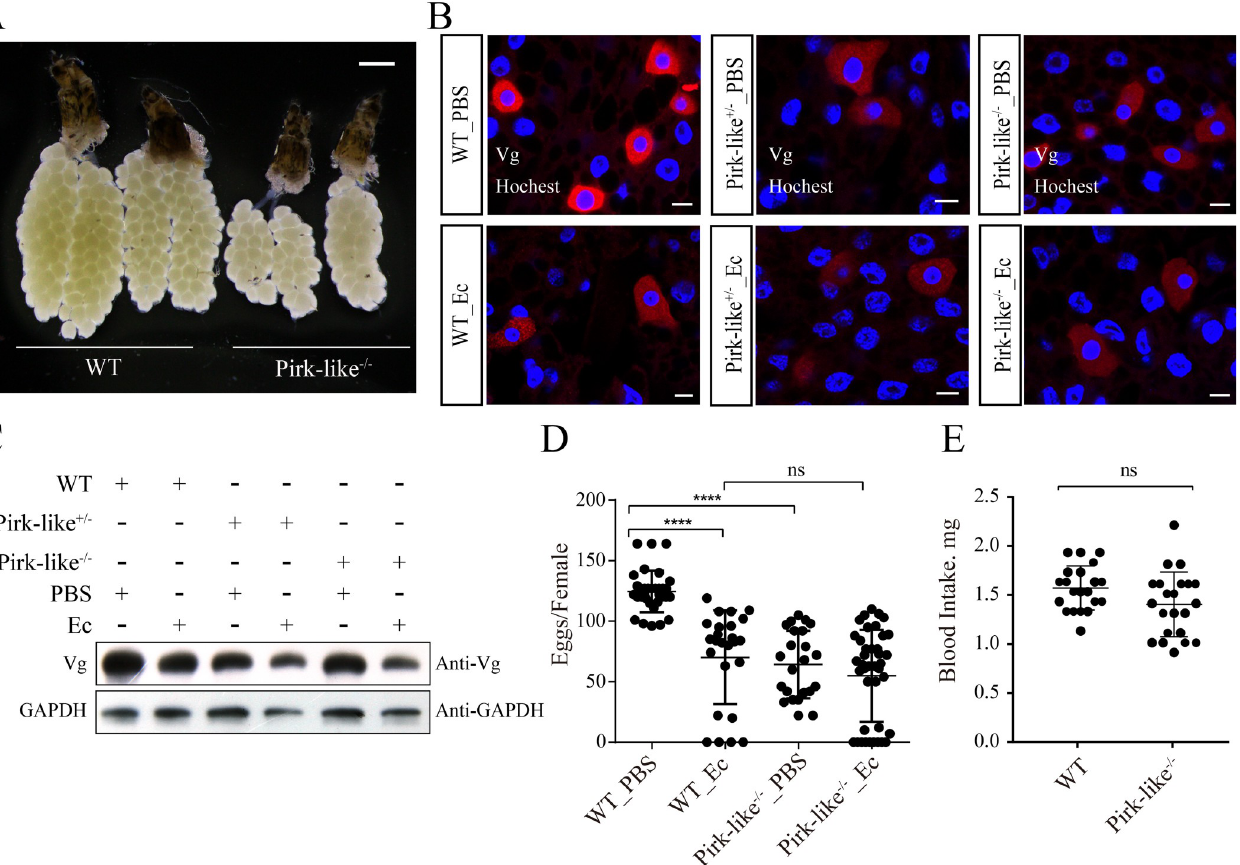
Fig 7. Knockout of Pirk-like impairs fecundity of mosquitoes. (A) Ovary development of WT and Pirk-like -/- mosquitoes at 36 h PBM. Data represent at least three biological replicates. (B) Immunofluorescence of Vg expression in WT, Pirk-like +/- and Pirk-like -/- mosquitoes was observed using a confocal microscope. Scale bar: 20 μ m. (C) WT, Pirk-like +/- and Pirk-like -/- mosquitoes either uninfected or infected with E . cloacae for 12 h were analyzed by means of western blots with Vg antibody. (D) Egg numbers of Pirk-like -/- and WT female mosquitoes that were stimulated with PBS or E . cloacae (OD600 = 0.8) at 12 h PBM. Data represent three biological replicates with three technical replicates and are shown as mean ± SEM. (E) Blood intake of female mosquitoes at the time after a blood feeding (0 h PBM).